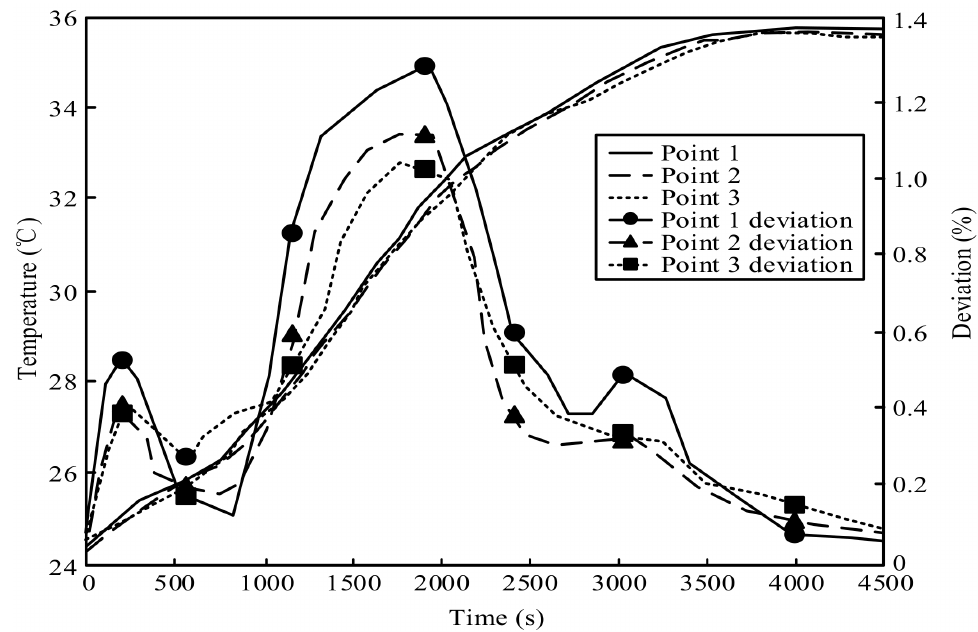
Figure 4. Analysis of the performance of the heat-generation model.